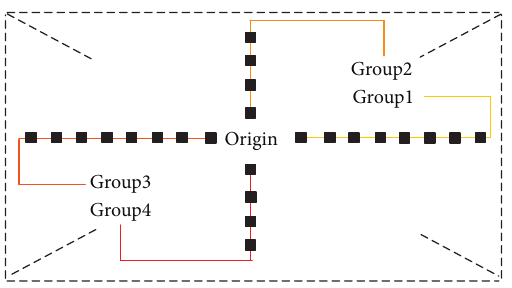
Figure 5: Modified unsymmetrical cross search pattern.